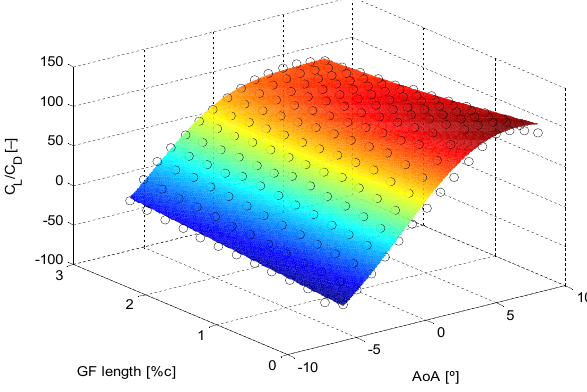
Figure 8. Neural network prediction surface of the CFD results of the airfoil aerodynamic performance C L /C D as a function of the GF length and the angle of attack (AoA). Black circles represent the CFD results.